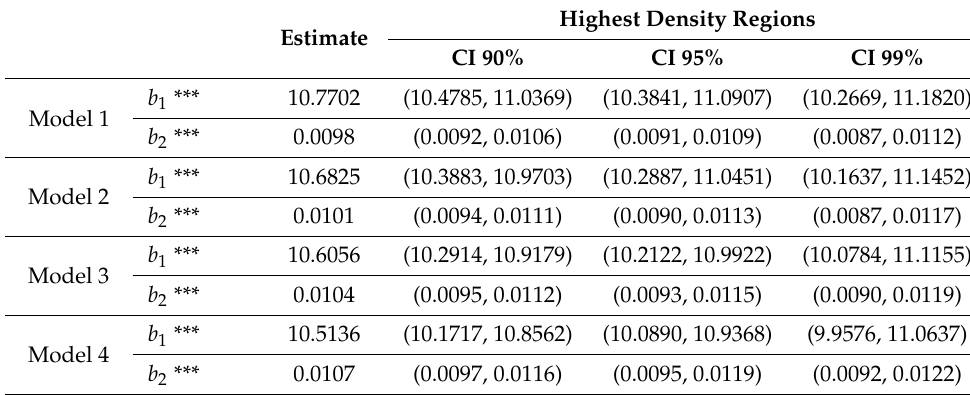
Table 4. Results for Model 1 to Model 4 (data from 1959 to